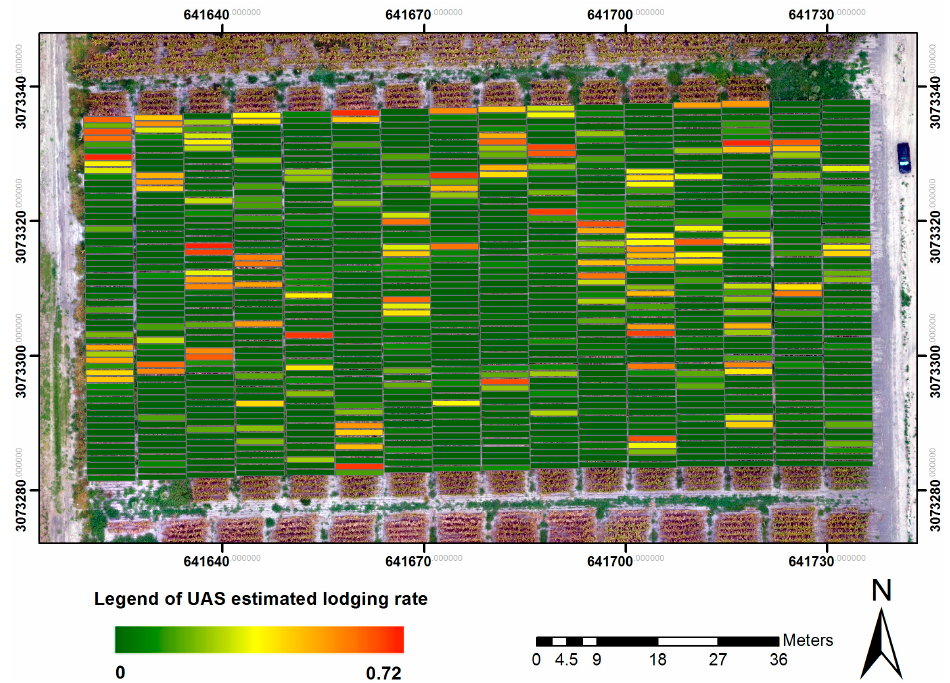
Figure 13. Overall UAS-based lodging detection results, within individual rows, on the lower portion of the field trial. Maize rows with relatively high and low lodging rates are represented by red and green polygons, respectively.